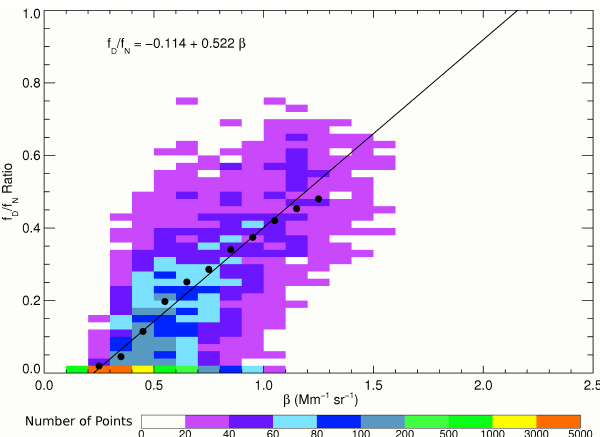
Fig. 3. Scatterplot of the daytime-to-nighttime aerosol detection fre- quency ratio ( f D / f N ) as a function of the mean backscatter of the detected aerosols, β , for 61 ◦ –71 ◦ N latitude from September through March, 2006–2012. Colors represent the number 5km orbit segments in each 2-D bin. Black circles correspond to the average value of (f D / f N ) for each value of mean backscatter. The straight line is the weighted reduced major axis linear fit to the black